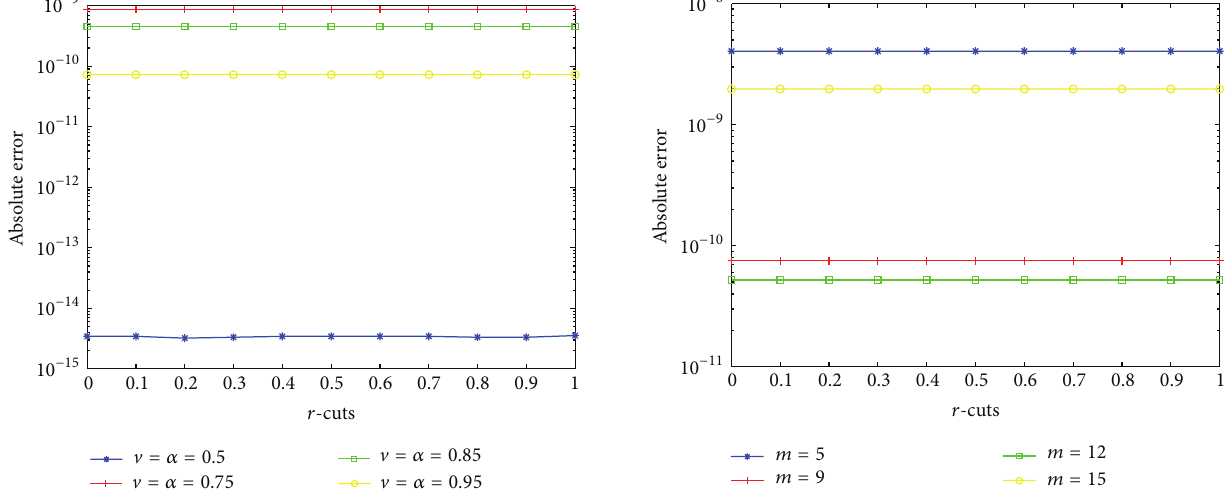
Figure 9: The absolute error for different values 𝑚 with V = 𝛼 = = 0.014 , and 𝑘 = 0.001 0.85 , 𝑘 1 2